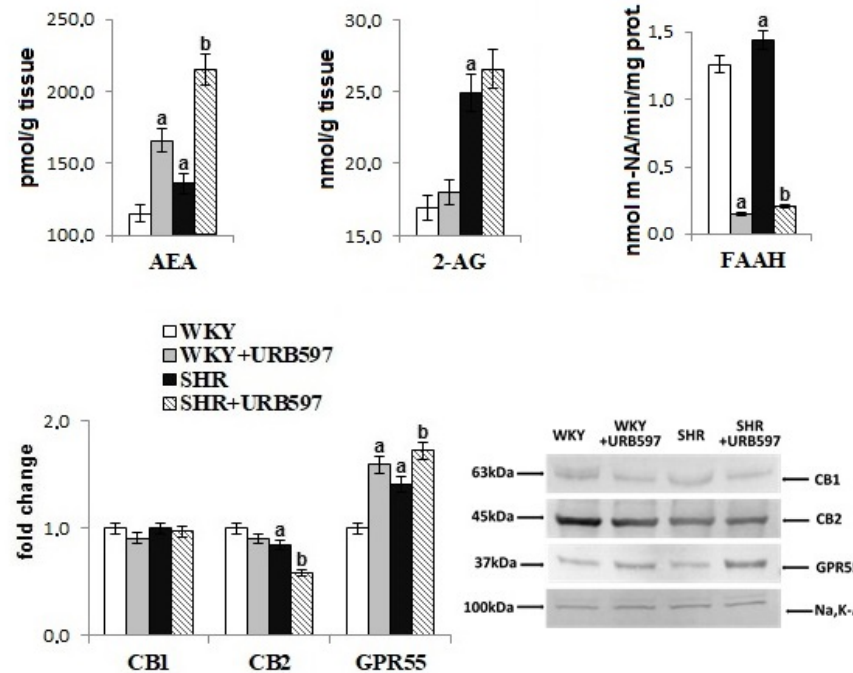
Figure 5. The level of endocannabinoids (AEA, 2-AG) and activity of enzyme-degrading endocannabinoids (FAAH) as well as expression of receptors (CB 1 , CB 2 , GPR55) in the brain of spontaneously hypertensive rats and hypertensive rats after URB597 administration. The expression of the examined proteins is shown compared to the control groups. Data points represent the mean ± SD, n = 6; (a, significantly different from the WKY group, p < 0.05; b, significantly different from the SHR group, p < 0.05).